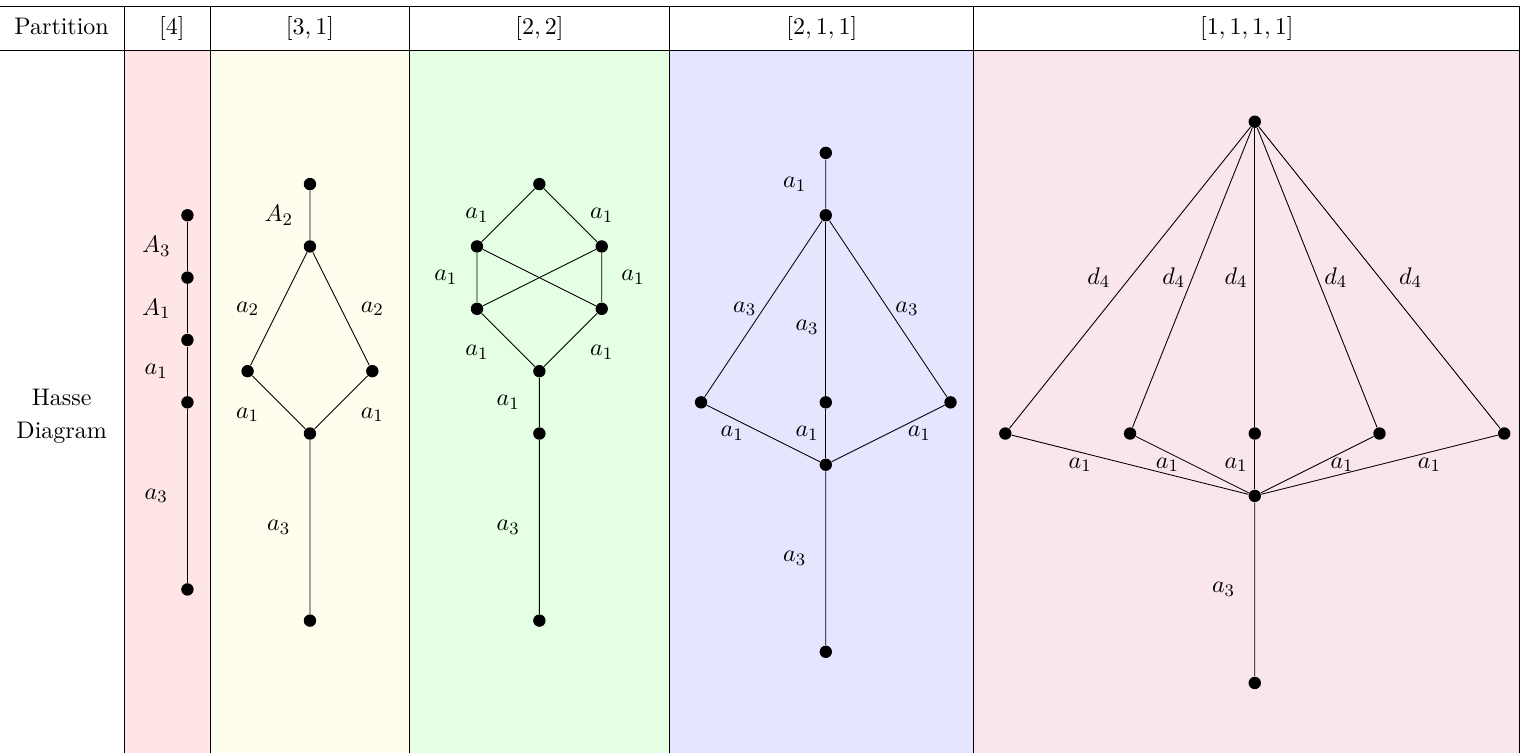
Table 5 . Hasse diagrams of symplectic leaves (black dots) for the Higgs branches of theories shown in tables 2, 4 and 3. The elementary slices between adjacent leaves are labeled A for the Klein singularity C 2 / Z and a (respectively d ) for the closure of the minimal nilpotent orbit n n +1 n n of sl ( n + 1 , C ) (resp. so (2 n, C ) ). The partition refers to hypers connecting the U(3) node and the bouquet of U(1) nodes in the second column of table 2, as indicated by the coloring of the